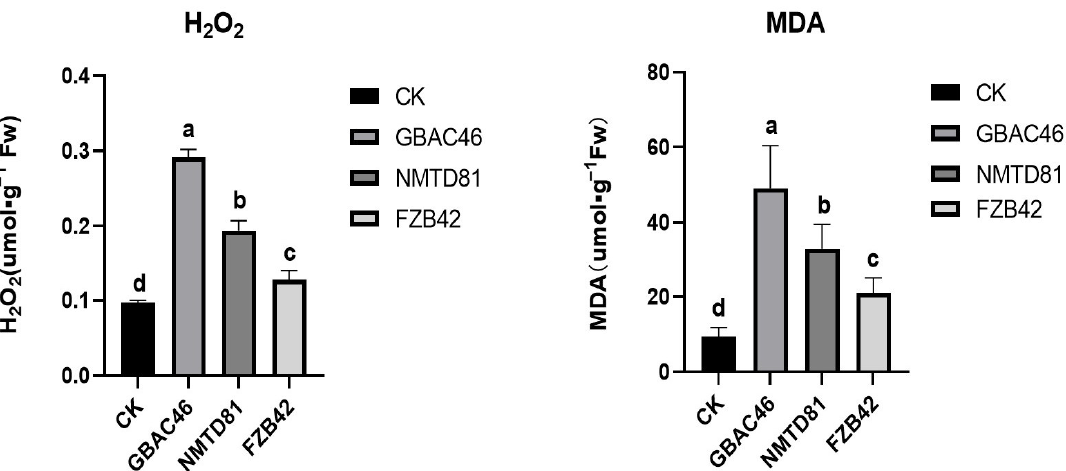
Figure 7. Determination of H 2 O 2 and MDA in the leaves of 30 day old seedlings following different treatments. The error bars indicate the mean standard deviation of each treatment when replicated three times. Significant differences are indicated by the letters above the columns. Fisher’s LSD test was used to determine significant differences between treatments at p ≤ 0.05.